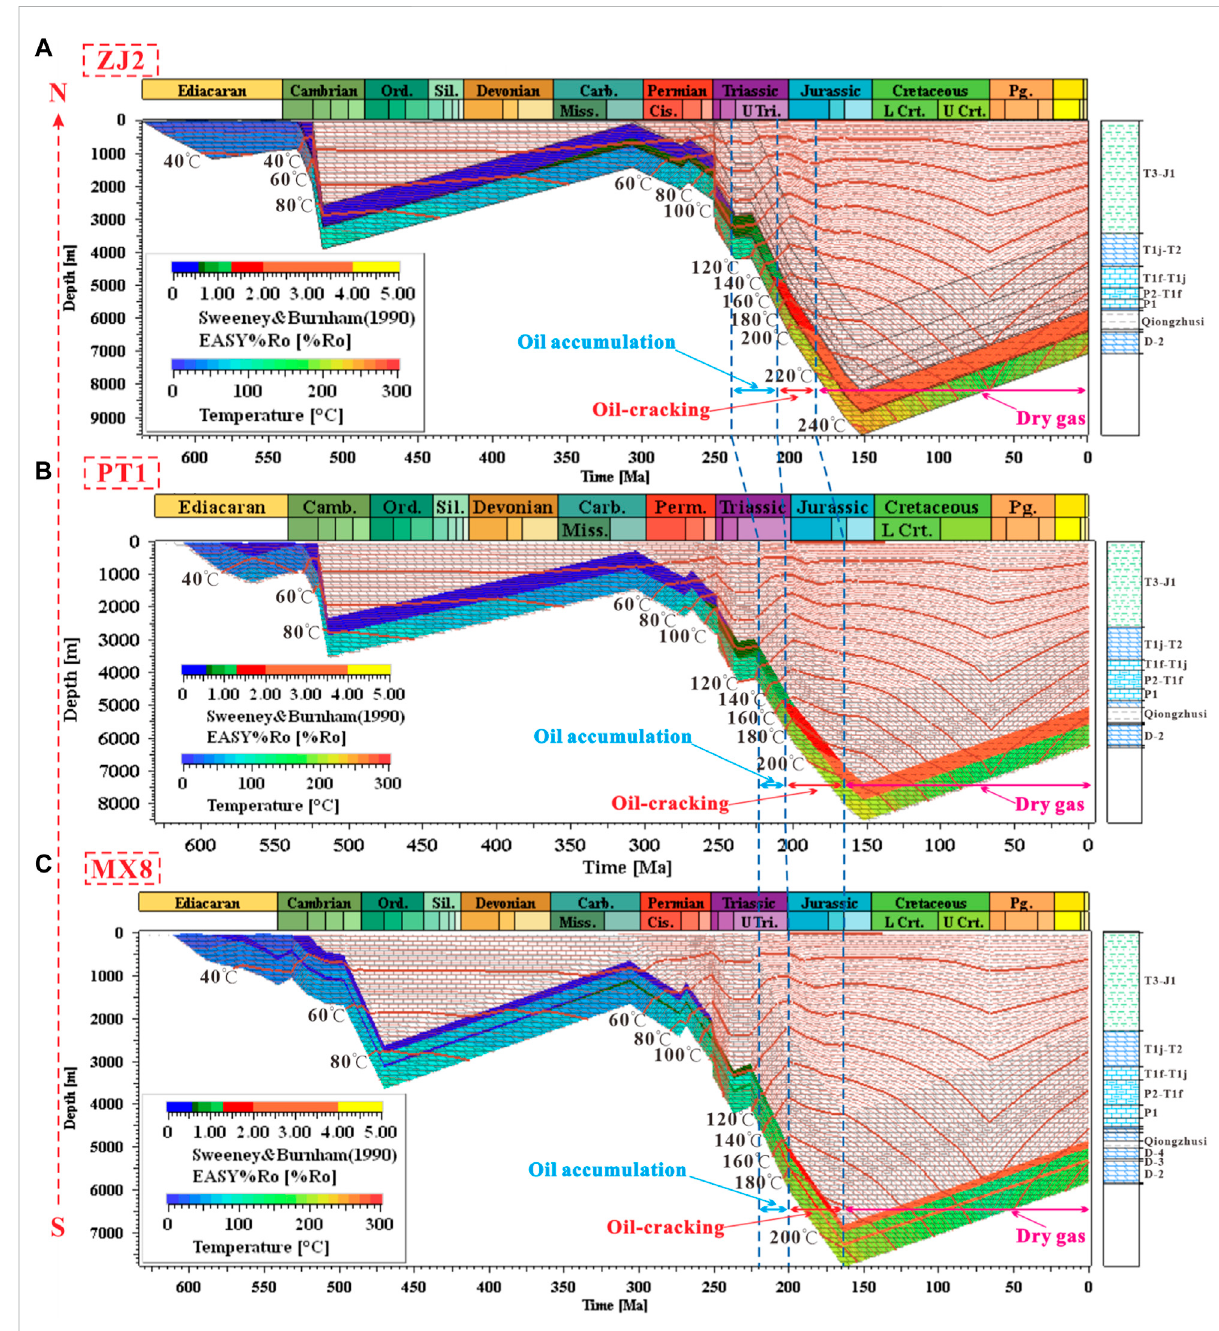
FIGURE 11 Burial and thermal evolution of the Upper Ediacaran Dengying reservoir and Lower Cambrian Qiongzhusi/Maidiping source rocks in the three blocks (the Moxi, Penglai, and Zhongjiang Blocks) of the central Sichuan Basin. (A) One-dimensional simulation for well ZJ2 of the Zhongjiang Block on the North Slope shows the burial history, the temperature evolution of Dengying reservoir, and the maturity of Qiongzhusi source rock. (B) One- dimensional simulation for well PT1 of the Penglai Block on the North Slope. (C) One-dimensional simulation for well MX8 of Gaoshiti-Moxi